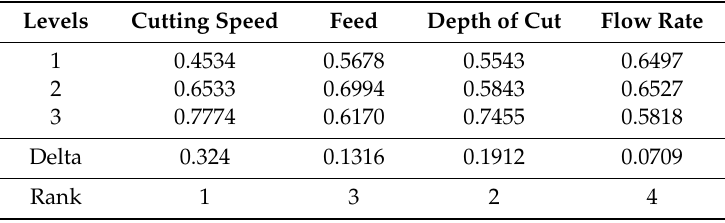
Table 9. Response table for Grey Relational Grade.